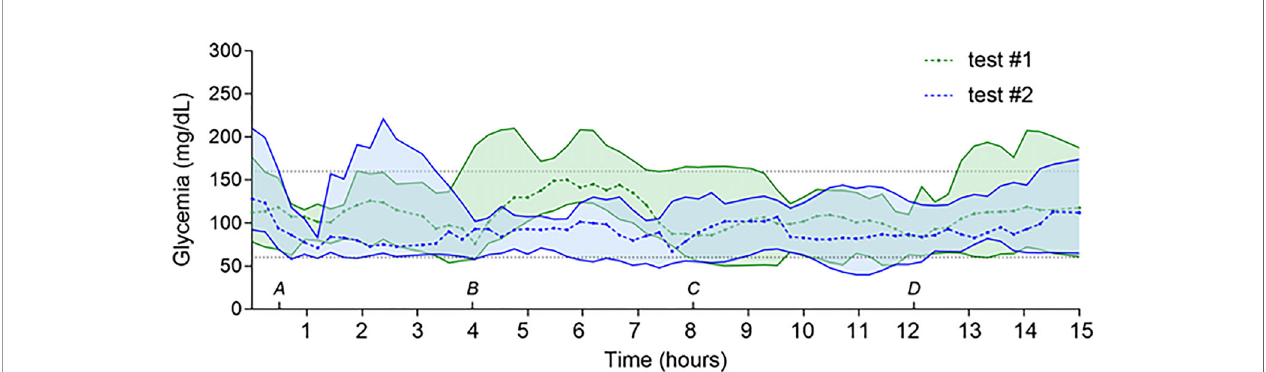
FIGURE 1 | Evolution of SG values during TE#1 and TE#2 in pediatric patients. Legend: Sixteen-hour evaluation of SG in pump and MDI groups during TE#1 (green) and TE#2 (blue) sessions. Gray dashed lines represent minimum (60 mg/dl) and maximum (160 mg/dl) target SG values. (A – D) delimitate the different evaluated time points: TE+0 – 0.5 h (ends at (A) , TE+0.5 – 4 h (afternoon – evening, starts at (A) , TE+4 – 8 h (evening – nighttime, starts at (B) , TE+8 – 12 h (nighttime, starts at (C) , and TE+12 – 15 h periods (starts at (D) . Data are expressed as median and interquartile